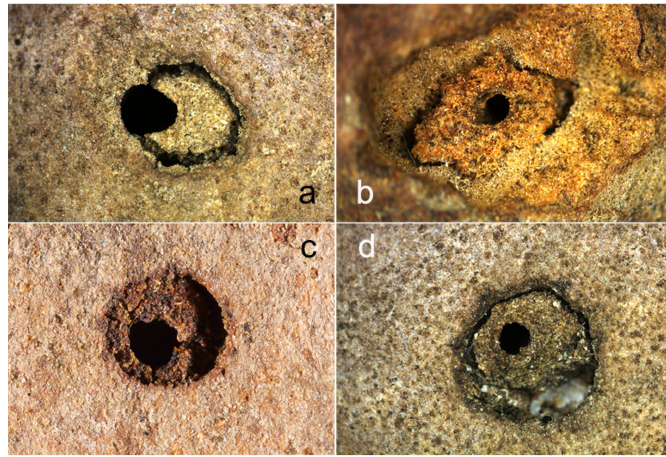
Figure 5. Gall entrance hole modified by Temnothorax spp. Pictures ( a – d ) show di ff erent examples of reduction of entry hole.